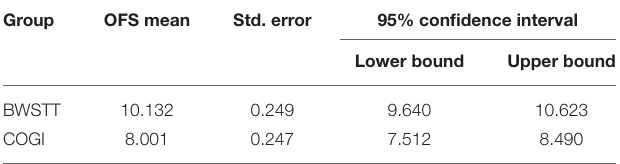
TABLE 2 | OFS total mean between BWSTT and COGI groups. TABLE 3 | T2 and T3 OFS evaluation in both